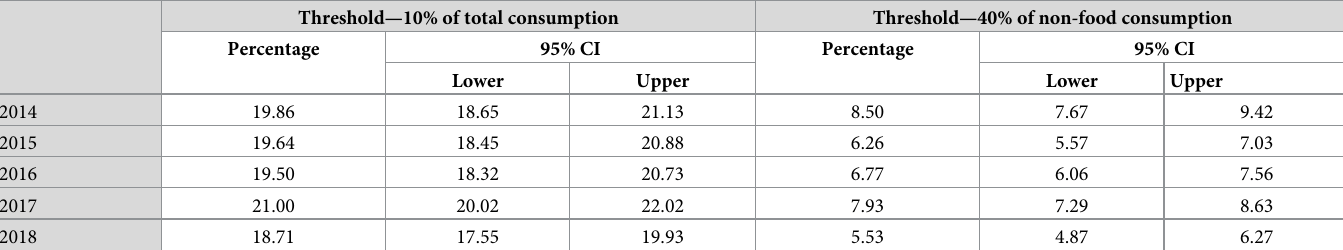
Table 3. Trends in the incidence of CHE among Armenian households.